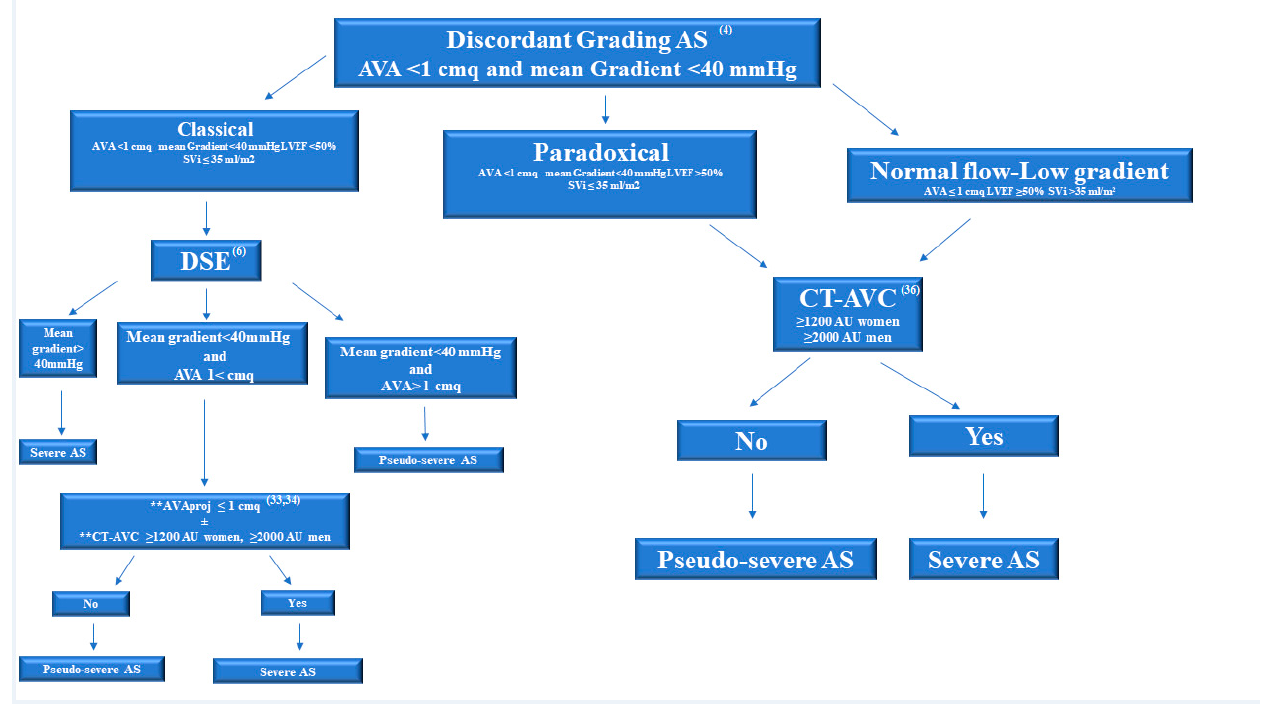
Figure 5. Stepwise integrated approach for the assessment of discordant grading aortic stenosis. AS: aortic stenosis; AVA: Aortic valve area; LVEF: Left ventricular ejection fraction; SVi: stroke volume index to body surface area; DSE: dobutamine stress echocardiography; AVA proj: projected area at standardized normal flow rate of 250 mL/s. AVA proj ≤ 1 cm 2 is considered severe; CT ‐ AVC: computed tomography aortic valve calcium scoring (severity cut ‐ offs: women ≥ 1200 AU and men ≥ 2000 AU); ** AVA proj and CT ‐ AVC are used because the stenosis severity often remains indeterminate at the outset of DSE, or echocardiographic assessments are discordant.